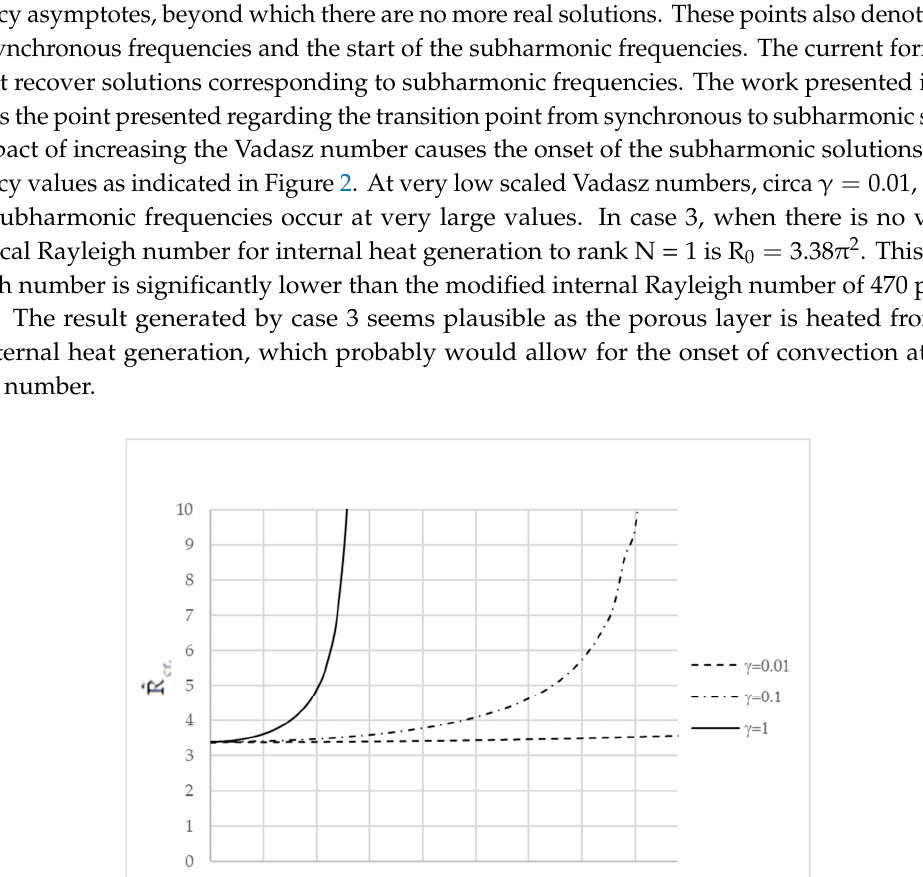
Figure 3. Critical Rayleigh number versus scaled Vadasz number at selected values of vibration frequency (Case 3: A = − 0.5).